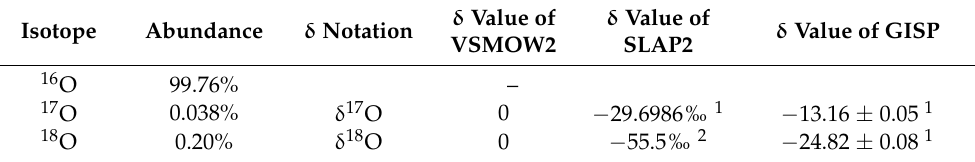
Table 1. Oxygen isotopes, abundances (relative %), δ notation, and δ values of standard materials. Isotope Abundance δ